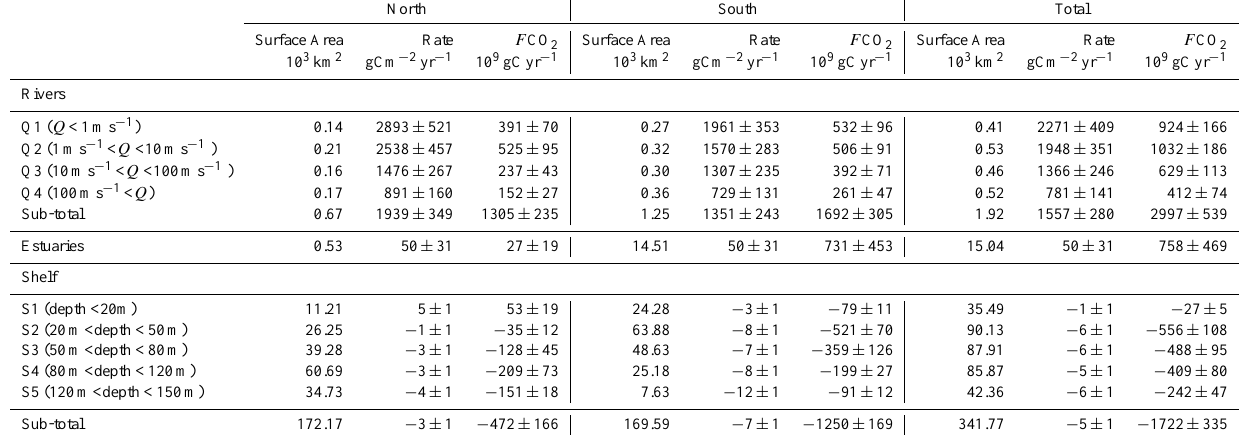
Table 2. Surface areas, CO 2 exchange rate with the atmosphere, and surface integrated F CO 2 for the North and South sections of COSCAT 827, subdivided by river discharge classes and continental shelf water depth